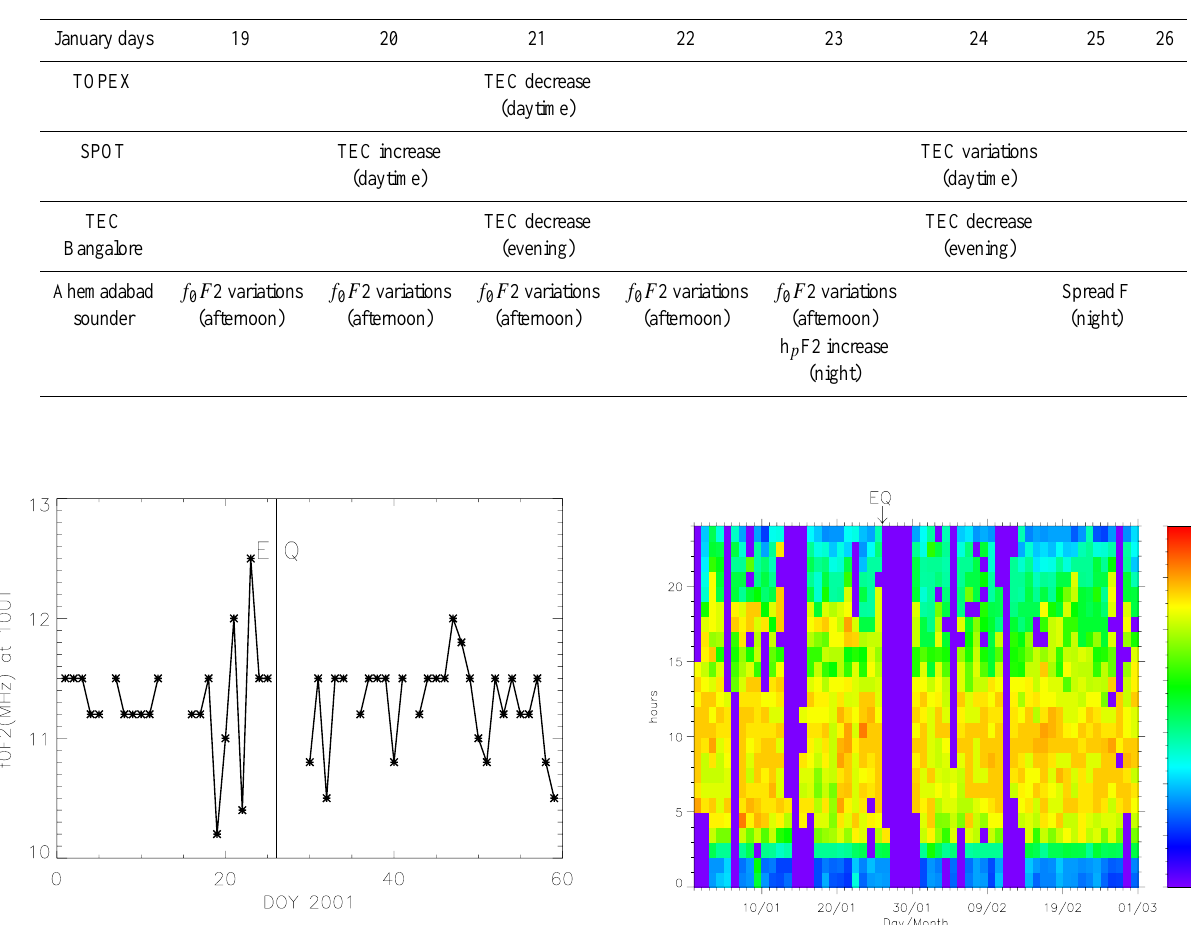
Table 2. Main ionospheric variations observed by various experiments before the Bhuj event.